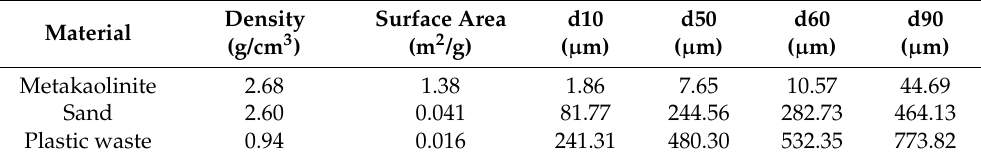
Table 3. Physical characteristics of the raw materials.